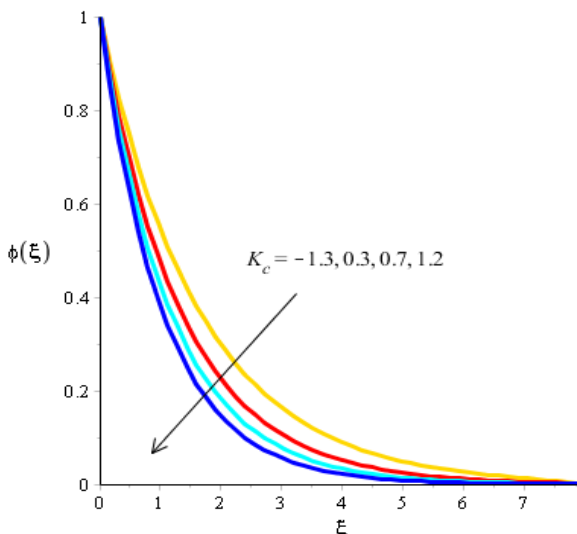
Figure 14. Analysis of concentration curves versus K c